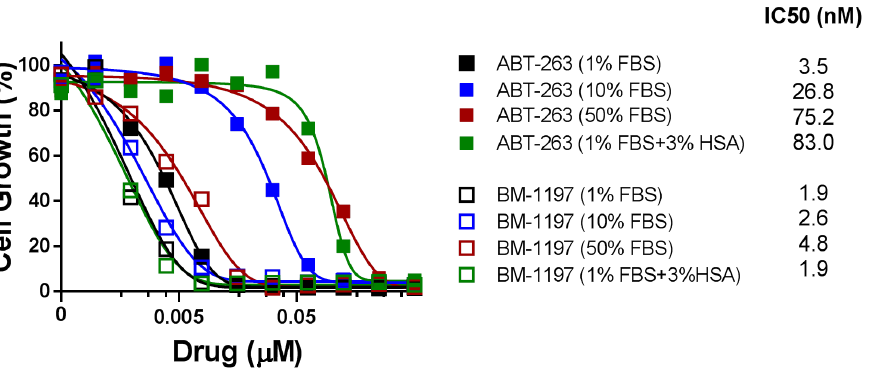
Figure 9. Albumin diminishes the growth-inhibitory activity of ABT-263 in H146 cells. H146 cells were treated with BM-1197 or ABT-263 in the presence of different concentrations of fetal bovine serum (FBS) or human serum albumin (HSA) for 4 days and the growth-inhibitory activities of BM-1197 and ABT-263 were evaluated by WST assay. Data are representative of two independent experiments.